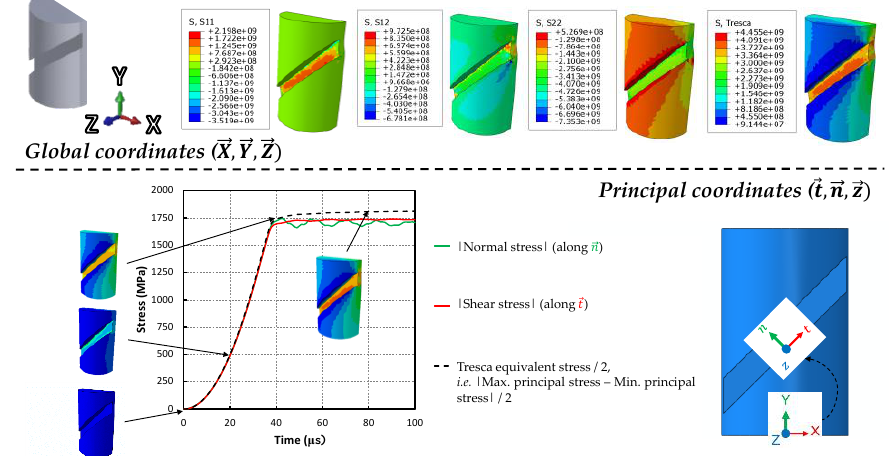
Figure 15. Comparison stresses in the global frame and plot of the normal and shear stresses in the local frame of the notch.